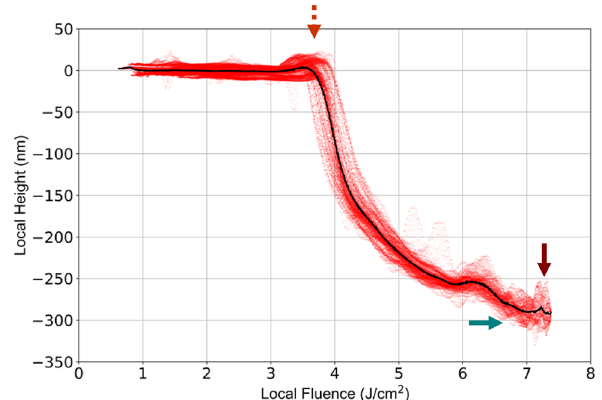
Fig. 3 Fluence map for sapphire. Data is from the sapphire crater pro fi le (1028 nm, 190 fs single pulse ablation at 30 μ J) and beam pro fi le of Fig. 2. Each individual red dot corresponds to a height data point of the crater pro fi le microscope data. Binned average values are shown in black. Characteristic morphological features can be interpreted from this single plot, such as the peak fl uence of the ablating pulse (dark red, solid), threshold fl uence (orange, dashed), and crater depth (blue,